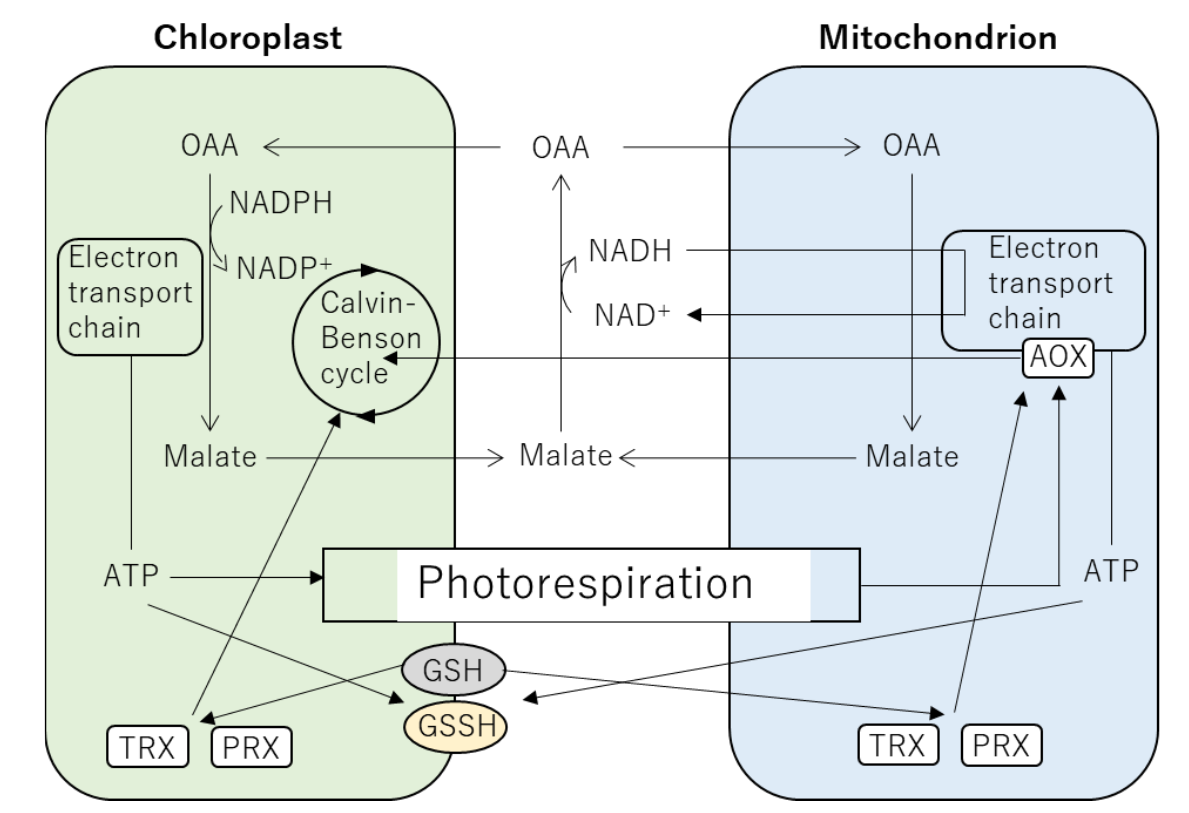
Figure 3. Integrations between the chloroplast and mitochondrion. Malate-OAA shuttle plays essential roles to prevent excess accumulation of reductants in the chloroplast, when photorespiration is accelerated. In this case, respiratory activity in the mitochondrion might shift to AOX-dependent to oxidize excess reductants in the mitochondrion. TRX and PRX modified by GSH in post-translation regulate proteins involved in the modulation of carbon assimilation, respiration and AOX.